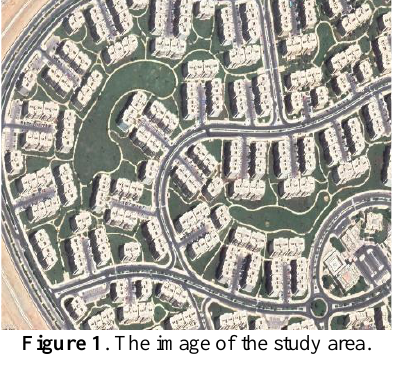
Figure 1 . The image of the study area.